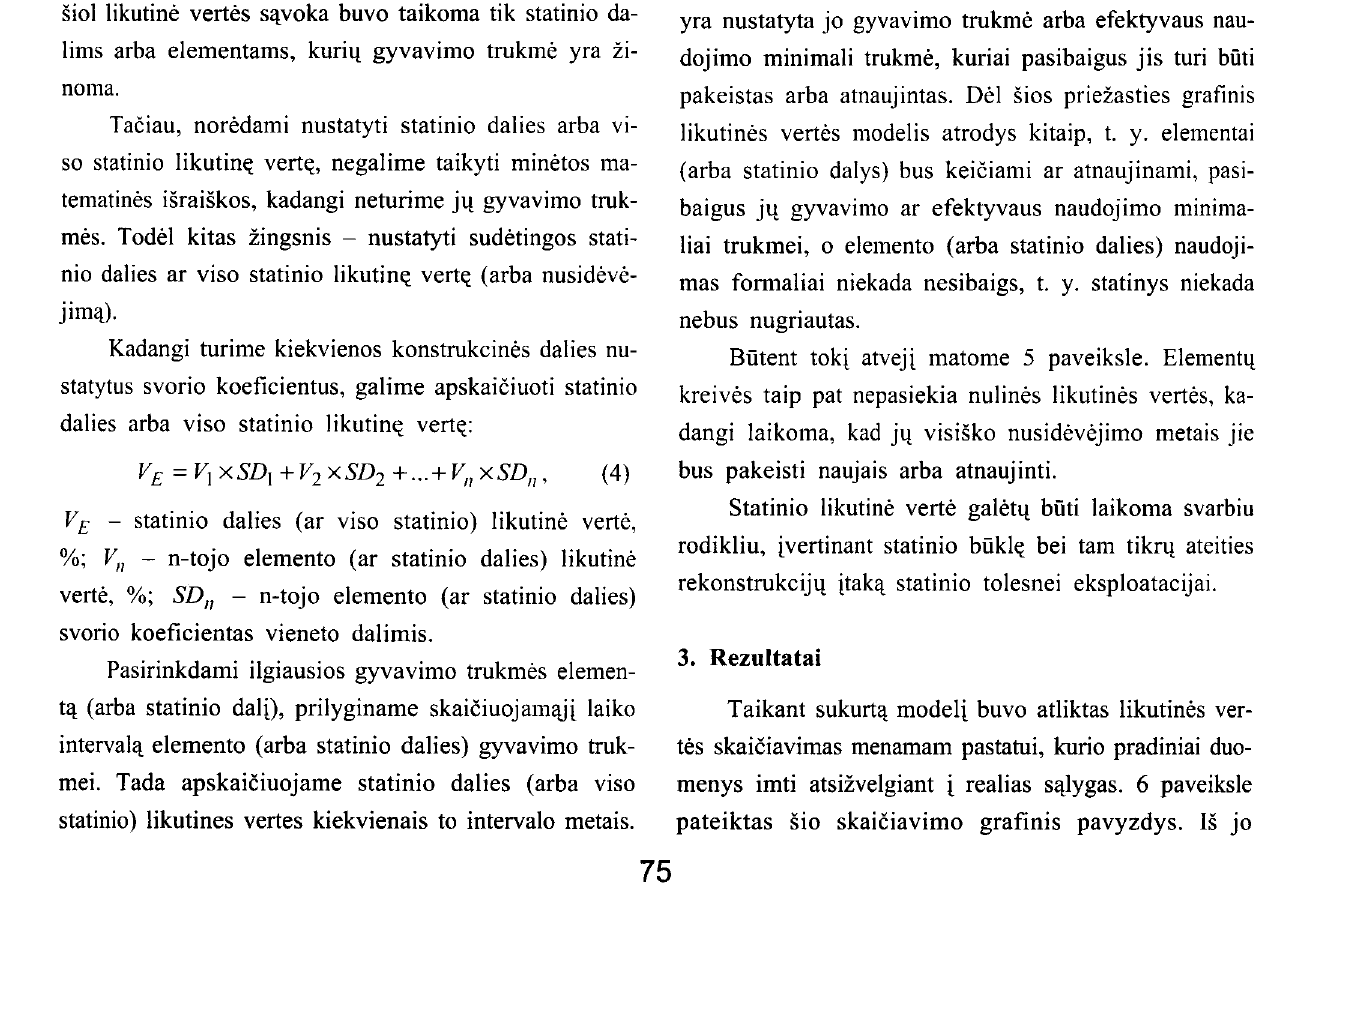
Fig 4. Example of roof depreciable value